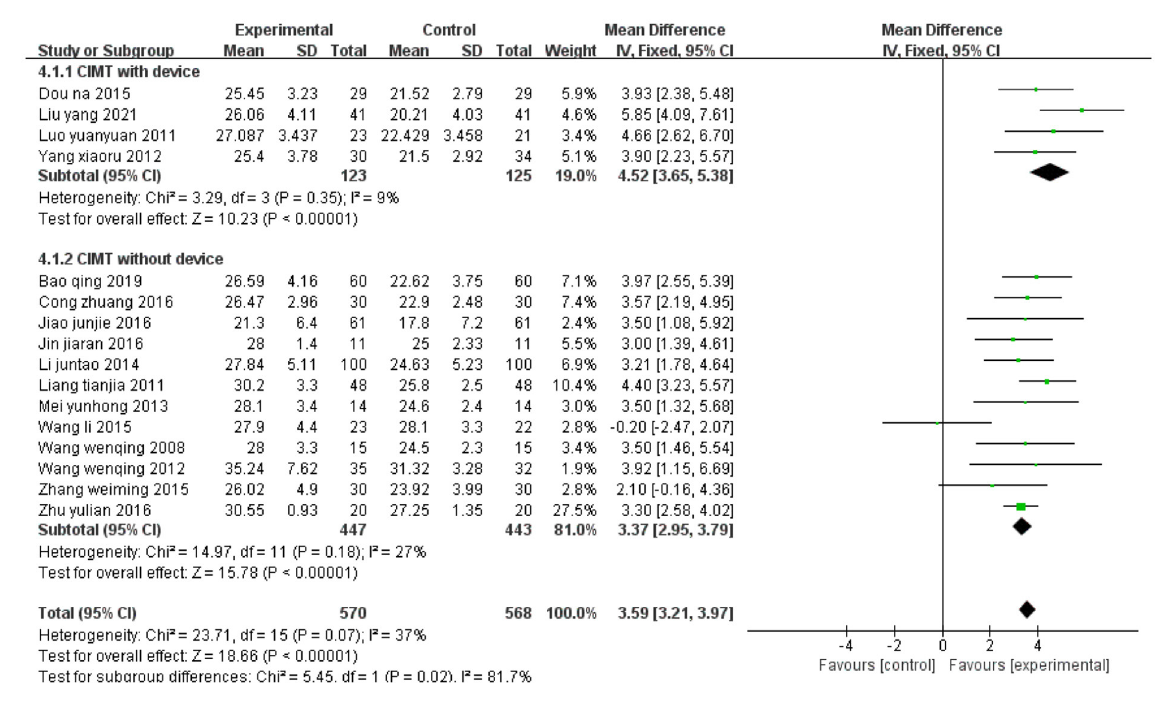
center may alter the biomechanics of the lower